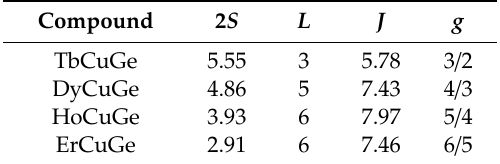
Table 1. Calculated spin 2 S , orbital L and total J moments, Lande factor g